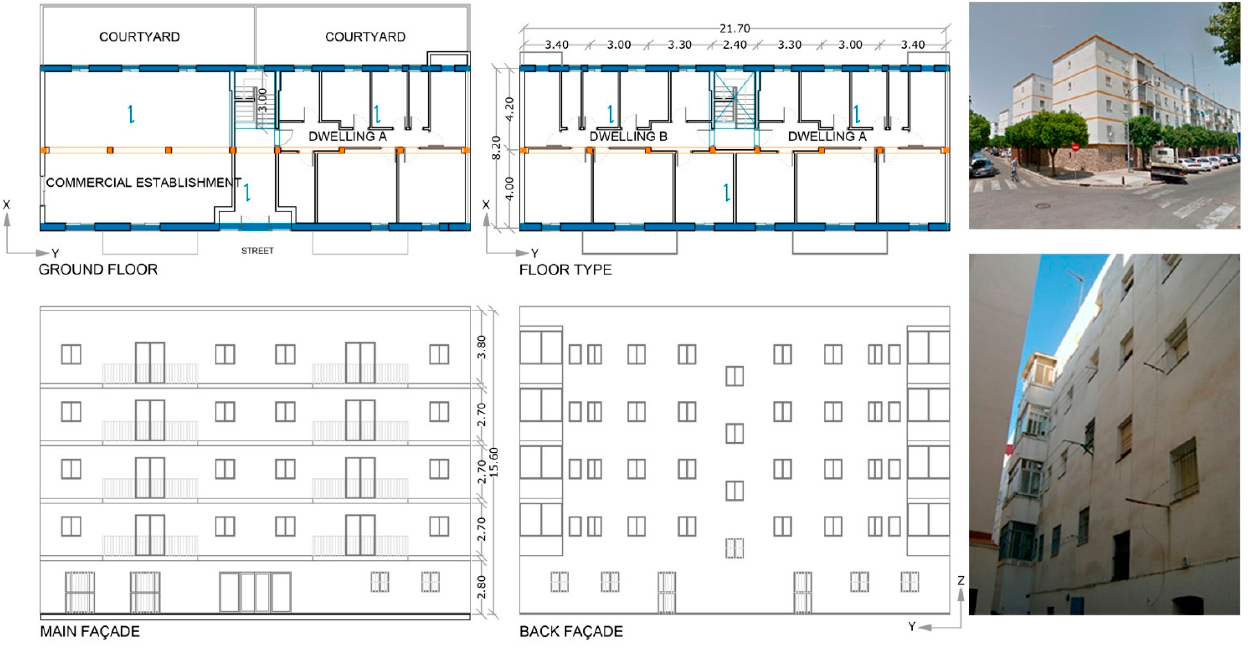
Figure 3. Structural configuration highlighting in blue the masonry walls and, in orange, the interior RC frame. Distribution in plan and elevation. Photos of the building (by the authors).